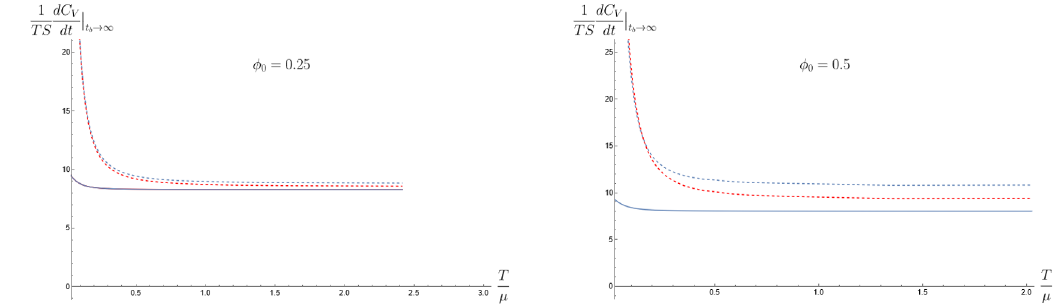
Figure 14 . In these pictures, we show W V / ( TS ) in solid line, (4 πM D ) / ( TS ) in blue dashed line and (4 πM N ) / ( TS ) in red dashed line (see eqs. (3.22), (3.26)) as a function of T/µ for a fixed φ 0 . Left: neutral scalar. Right: charged q = 1 scalar. The Lloyd bound is always satisfied for both the Dirichlet and the Neumann definition of